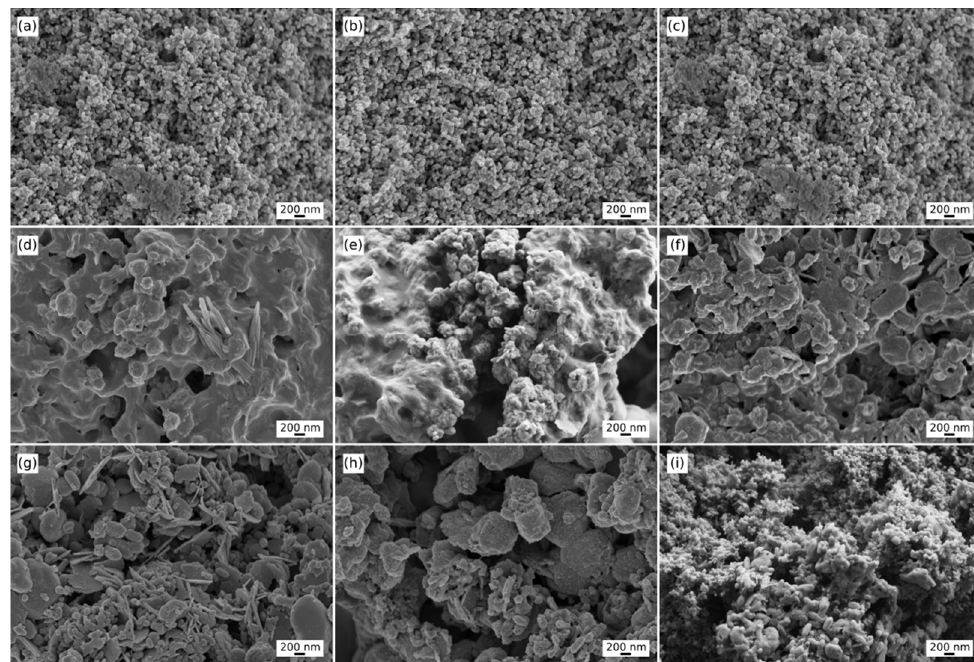
Figure 3. SEM images of the different samples. Images from the upper row, ( a – c ), depict the Surface of pure HAp nanorods. The central row, ( d – f ), corresponding to the HAp:GD1 samples and the lower row, ( g – i ) represents the results of the HAp:GD10 material. It can be seen in the untreated images that the incorporation of gadolinium causes a softness in the appearance of protuberances and a general change in the complete